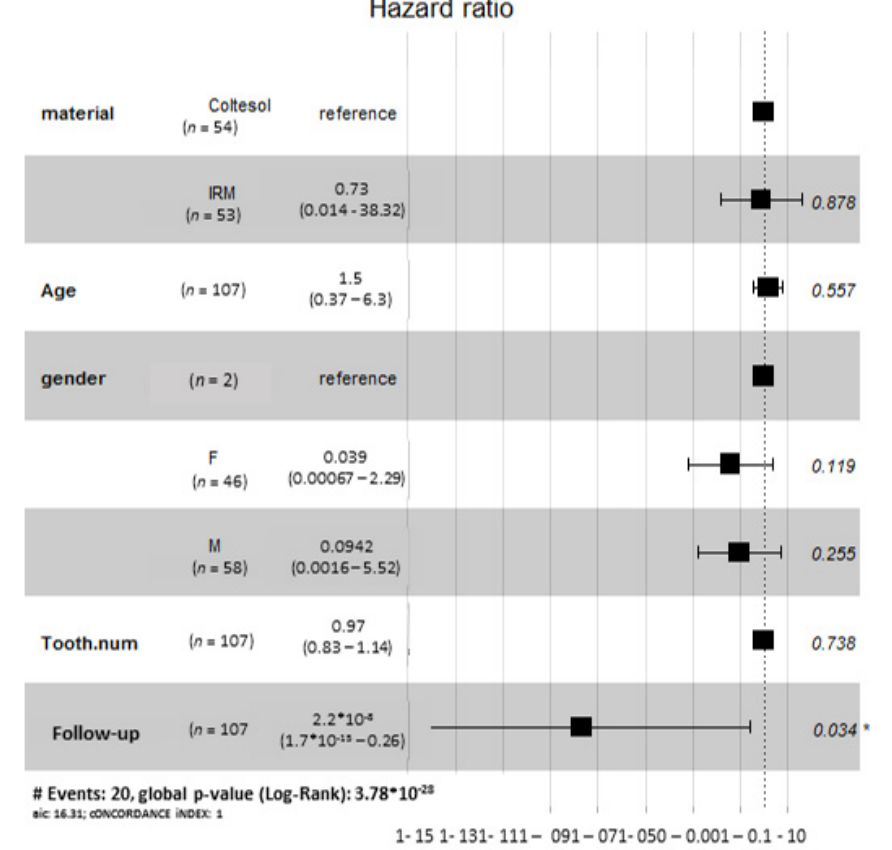
Figure 2. Cox proportional hazards model results. Failure is the dependent variable. The independent variables are gender, age, tooth type, and material (IRM/Coltosol) type. The analysis showed that the only variable that significantly influences the risk of treatment failure in this study is the follow up